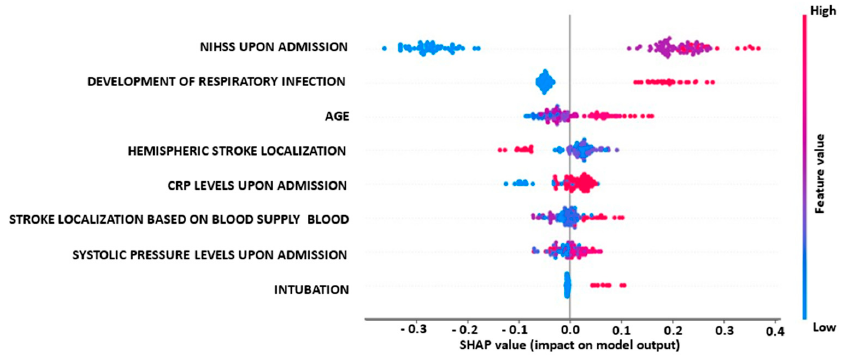
Figure 6. Biomarkers’ impact on RF model output for the prediction of mRS at independent vs. non-independent task.